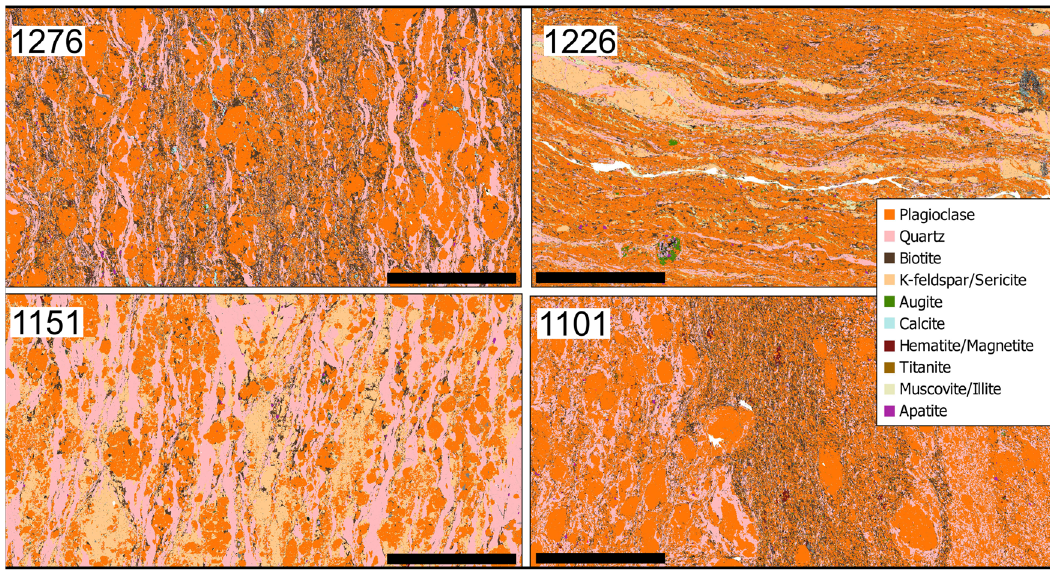
Fig. 2 False color mineral maps of Akia Terrane mylonites. Tescan TIMA mineral identi fi cation images of thin sections from various mylonites in tonalite and felsic gneiss, Akia Terrane, Greenland. The black bar in each thin section image denotes a 10 mm